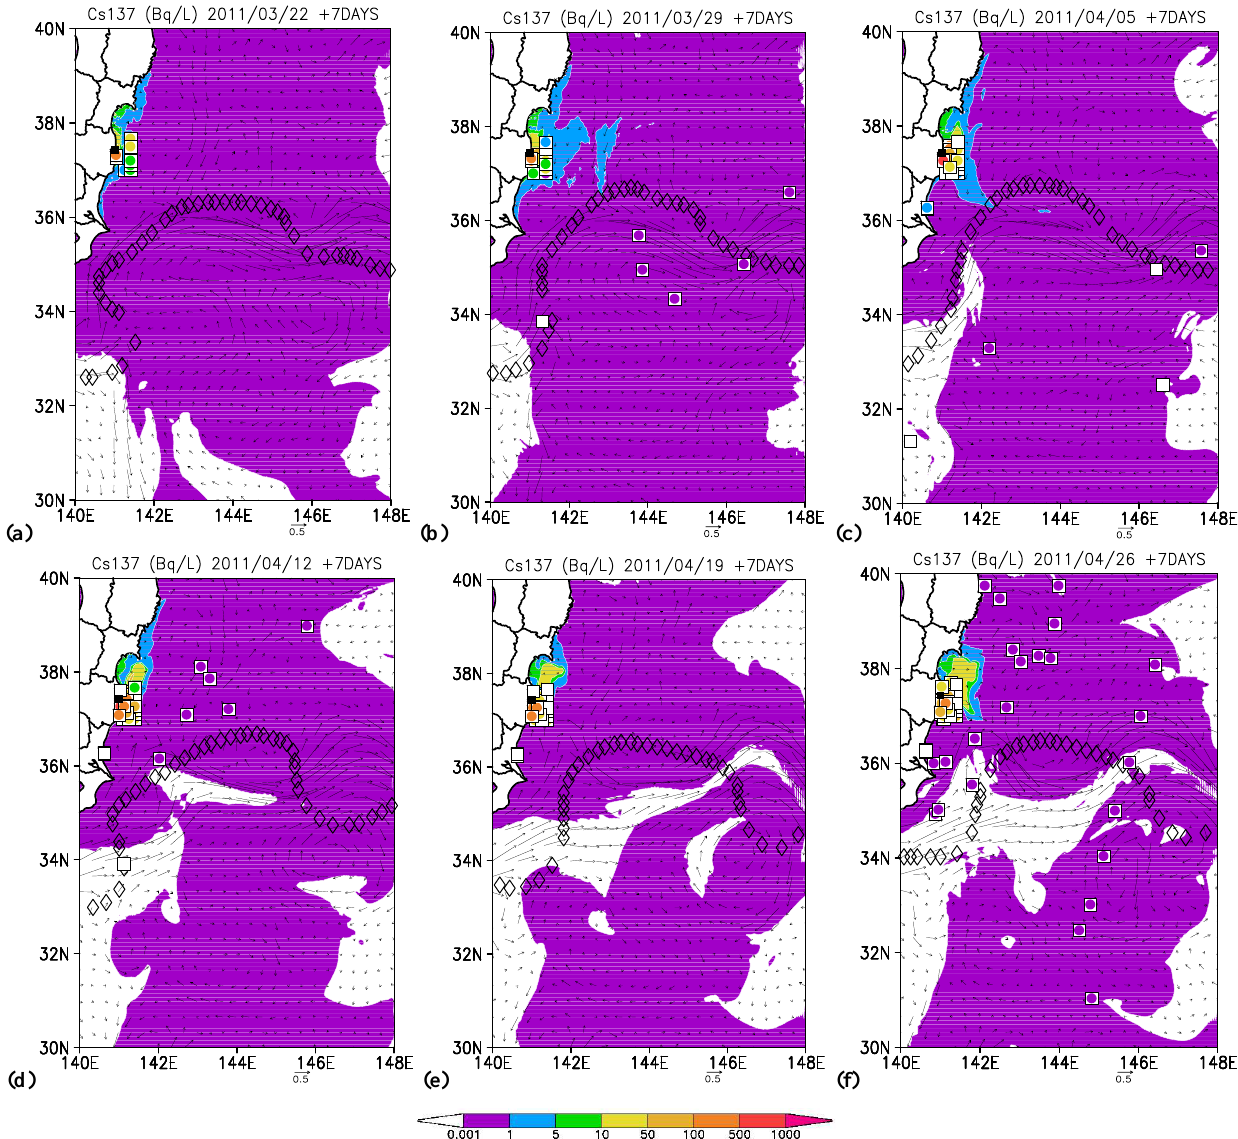
Fig. 9. As in Fig. 7, except for showing a wider region, and with open diamonds indicating the position of the Kuroshio Extension front provided by the Japan Coast